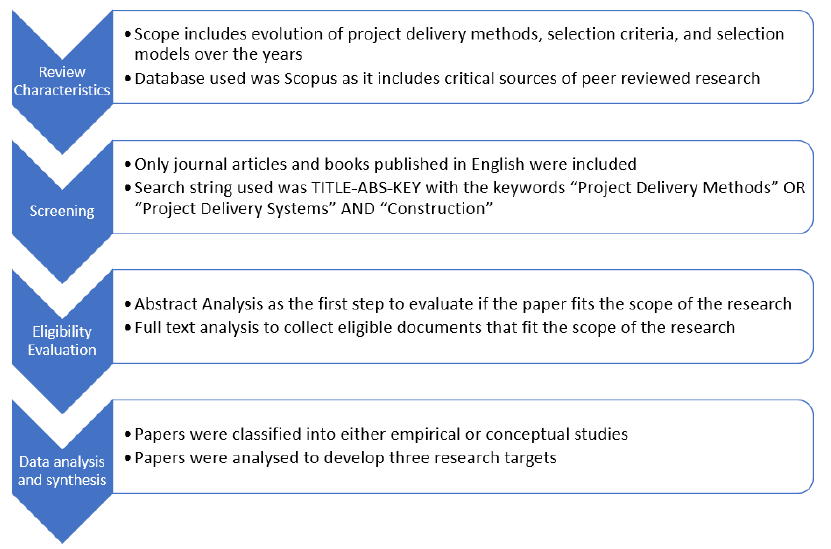
Figure 1. Preferred reporting items for systematic reviews and meta-analyses (PRISMA) checklist.